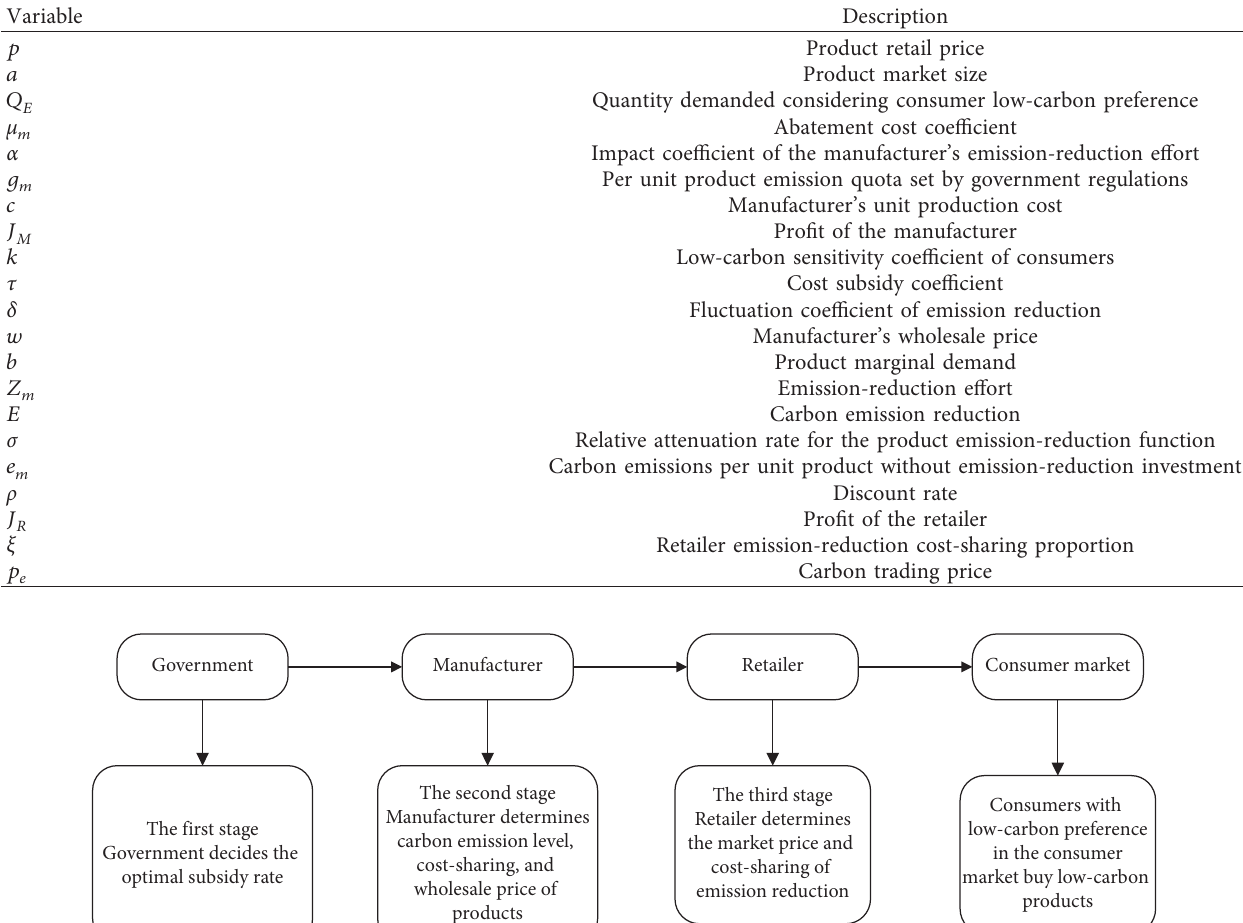
Table 1: Description of the parameters of the model.